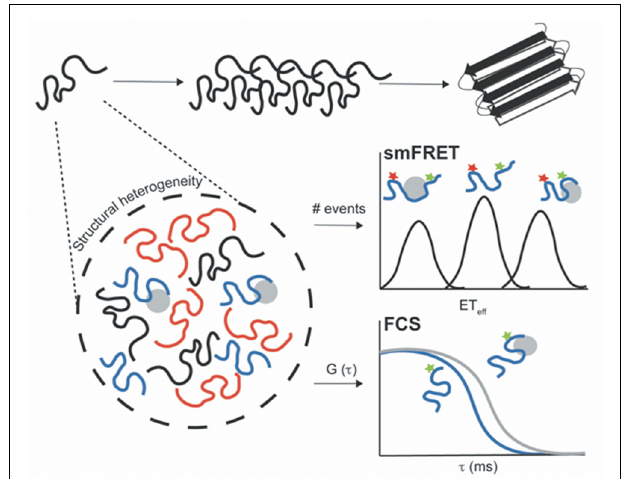
FIGURE 1 | Untangling the conformational heterogeneity and molecular interactions of monomeric intrinsically disordered proteins (IDPs) through single-molecule fluorescence (SMF) approaches. Single-molecule Förster resonance energy transfer (smFRET) histogram discriminating between distinct conformational ensembles of double-label protein (donor–acceptor): monomeric free protein in solution and bound states with extended (low ET eff ) or compacted conformations (high ET eff ). Fluorescence correlation spectroscopy (FCS) autocorrelation curve reporting on changes in the diffusion time of single-label protein free in solution (blue curve) and upon interaction with aggregation inducers or binding partners (gray curve). The binding results into a shift of the autocorrelation curve to the right (longer translational diffusion